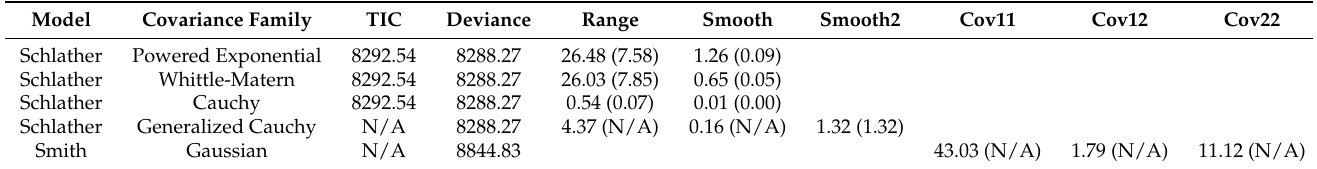
Table 7. Max-stable process fitted to the second cluster of the annual maximum temperatures.